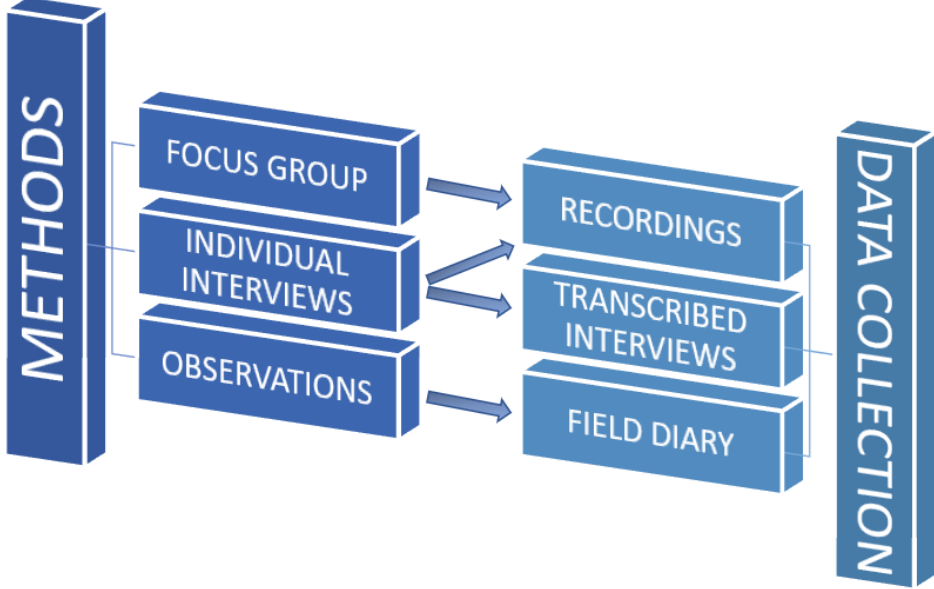
Figure 1. Methods and data collection.